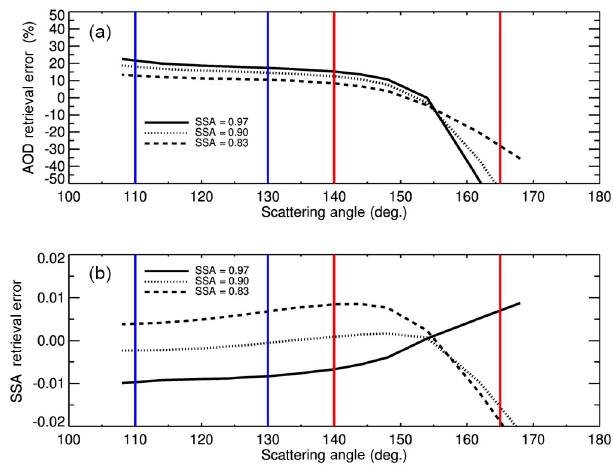
Figure 6. Percentage of error in retrieved AOD (a) for a non- spherical aerosol polydispersion of optical depth 1.0 (500nm), as- sumed to be spherical in the retrieval process. Calculations were done for different SSA values: 0.97 (solid line), 0.90 (dotted line) and 0.83 (dashed line). Vertical lines indicate the range of scattering angles in Fig. 3 for rows 1–30 (blue) and rows 31–60 (red). Panel (b) shows the resulting absolute error in retrieved SSA associated with the spherical particle assumption. See text for